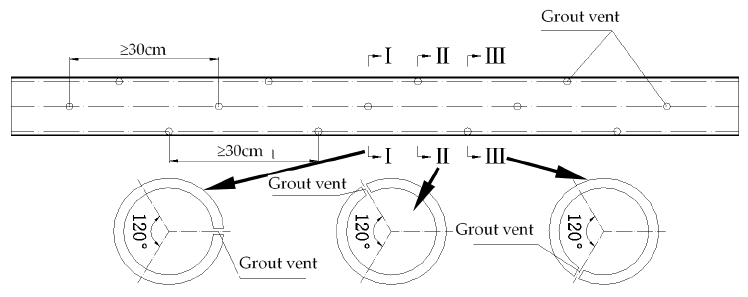
Figure 5. Arrangement parameters of grout vents in the body of the casing.